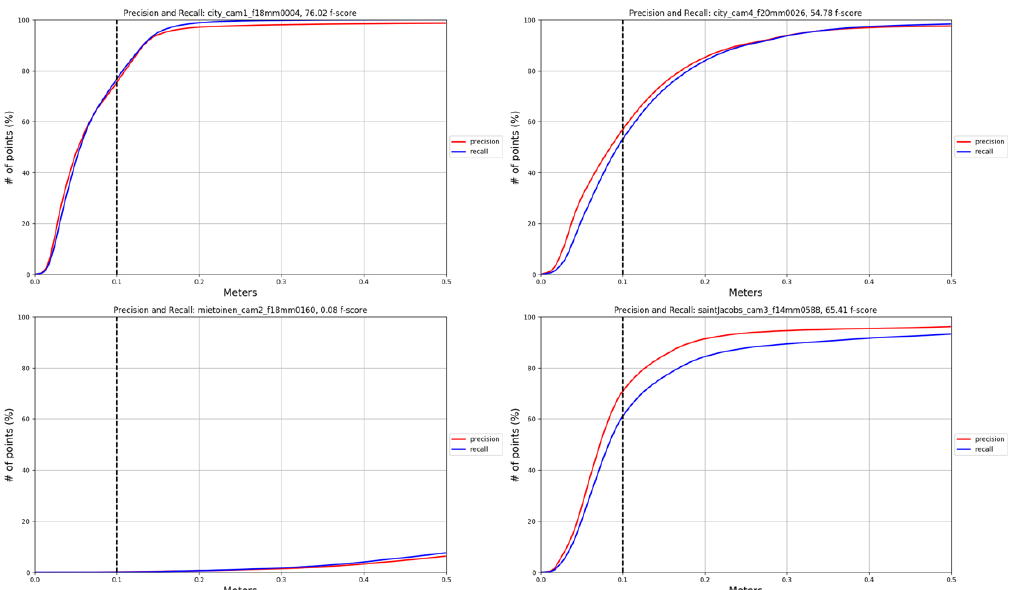
Figure 6. Experiment 1. Precision and recall curves for the four test images in Figure 5.